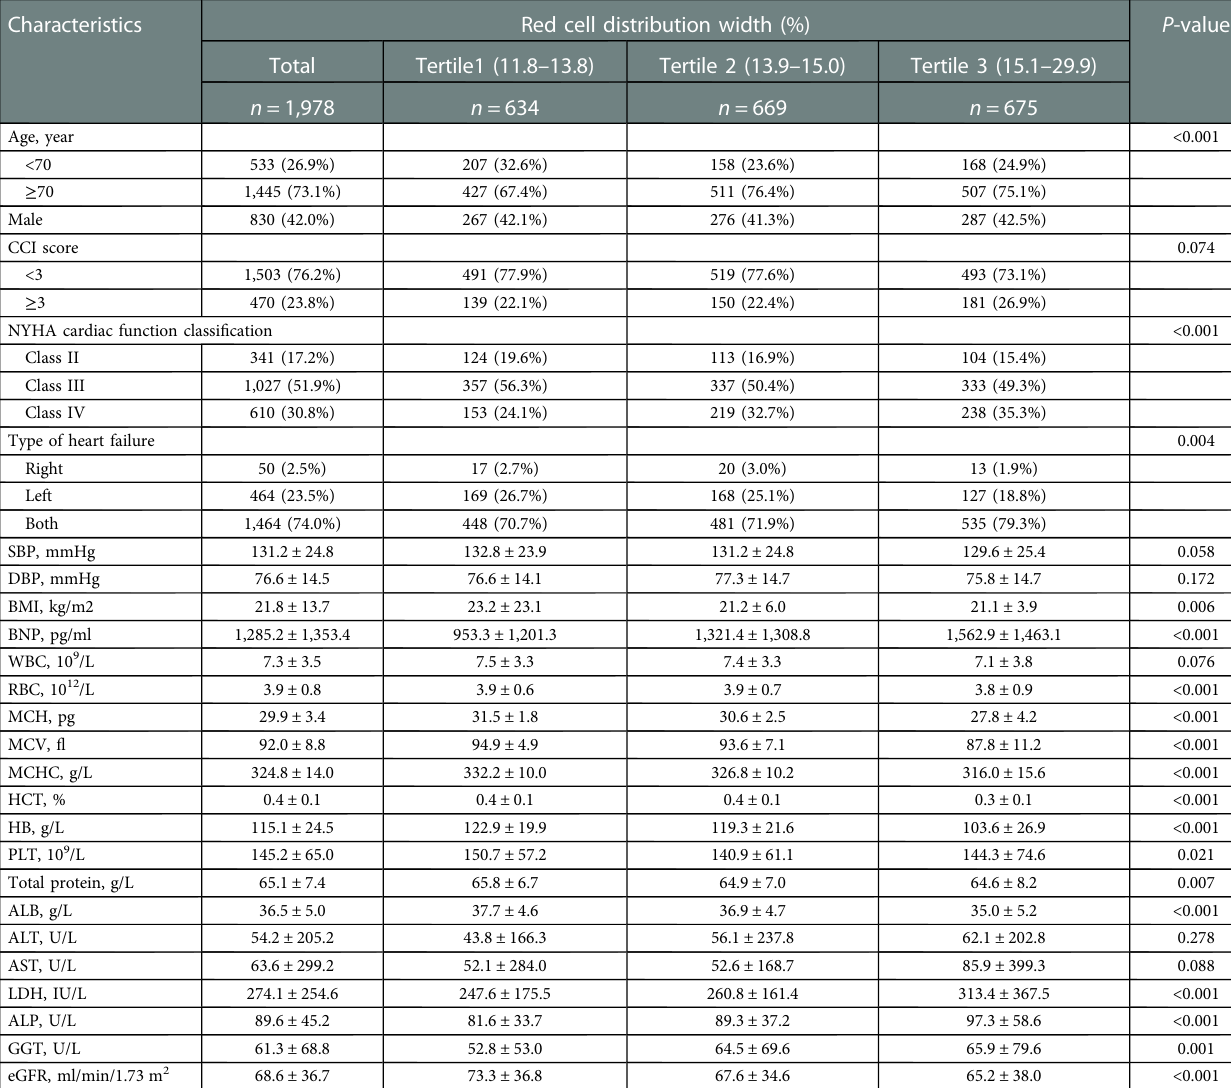
TABLE 1 Baseline characteristics of the